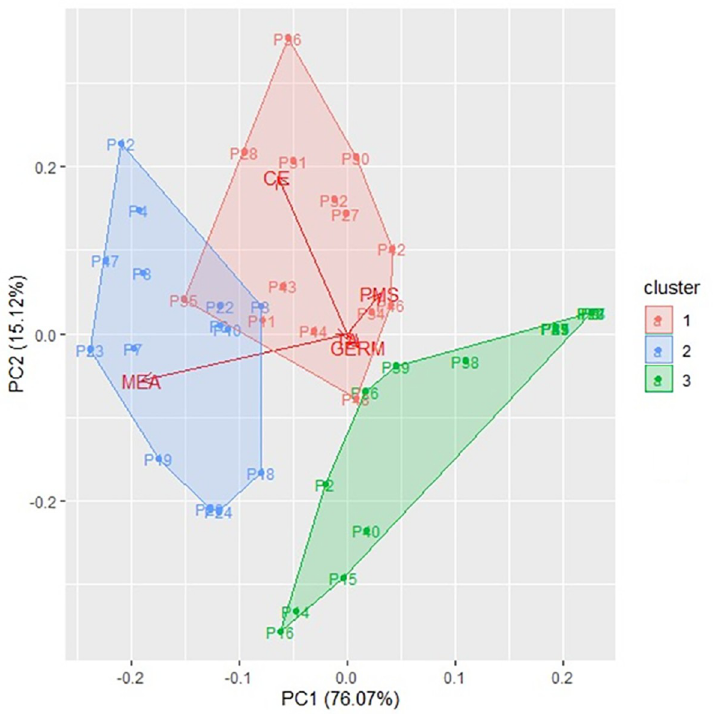
Fig 8. PCA analysis and grouping of conditions, packaging, and storage time for seeds of RR and RR2 soybean cultivars regarding physical and physiological quality.